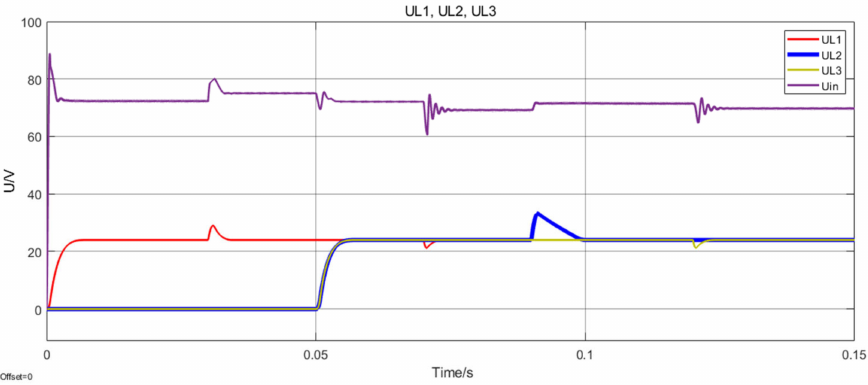
Figure 15. The output voltage of each load and the input voltage U in of Buck circuit. Figure 15 represents a three-load system. When t = 0.05 s, load #2 and load #3 start with R eq2 = 3 Ω and R eq2 = 10 Ω , respectively. At this time, it can be seen that the output voltage U L1 of the load #1 has not fluctuated and has been maintained at 24 V. At t = 0.09